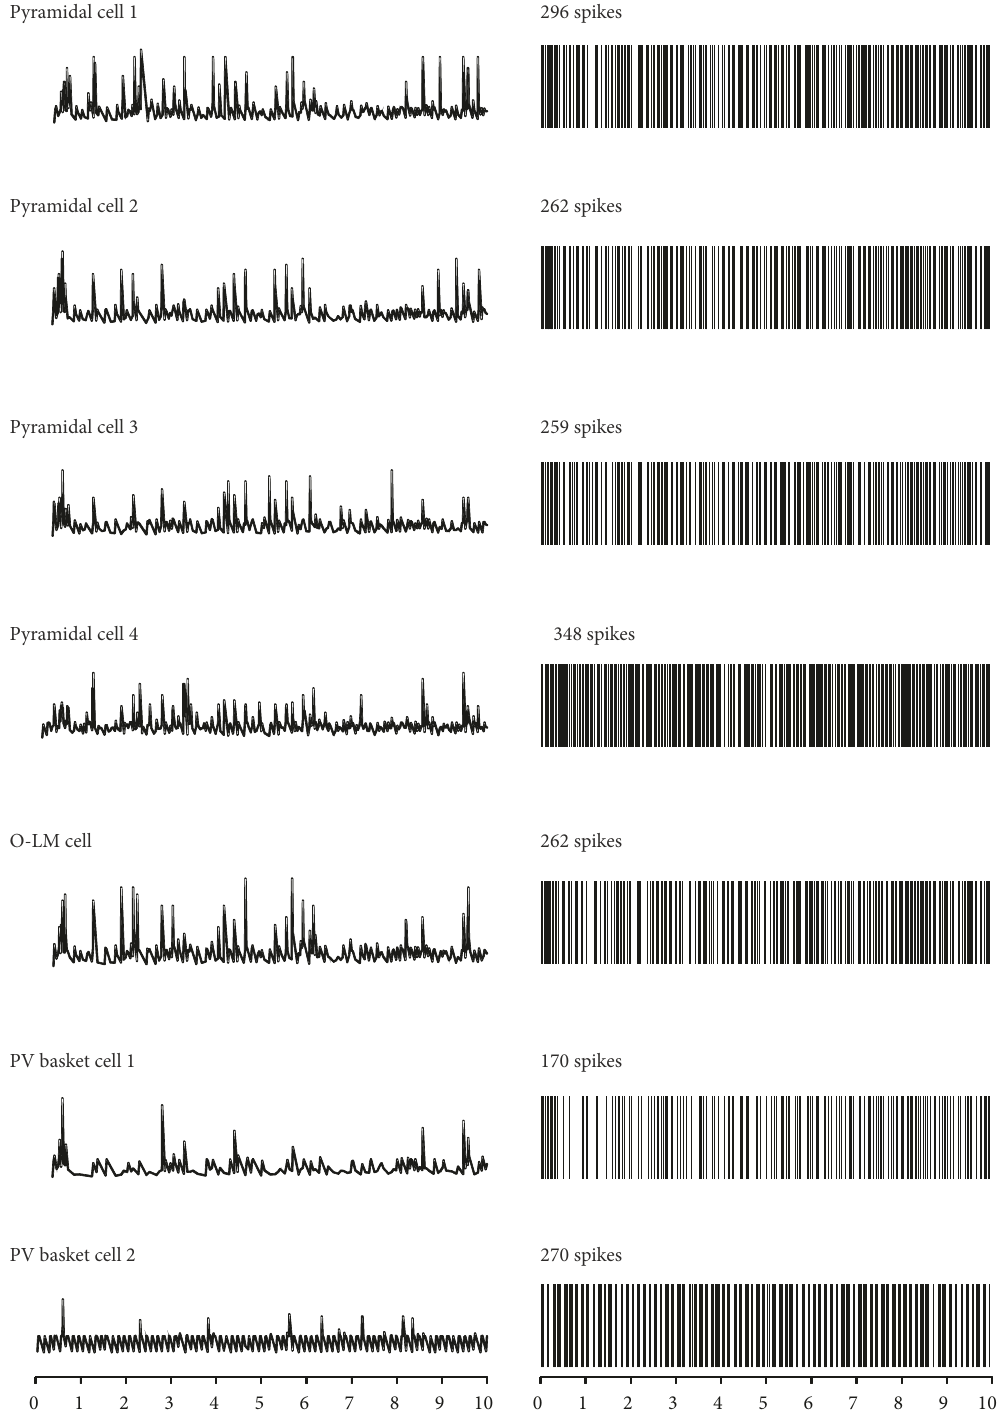
Figure 3: Basic 10-second real-time simulation of pyramidal cells, basket cells, and OL-M cell with LTP inducing protocol. On the left, time course of summarized postsynaptic potential for all cells of CA1 region. On the right, output spikes train. Time (s), forecast time of duration LTP at the end of